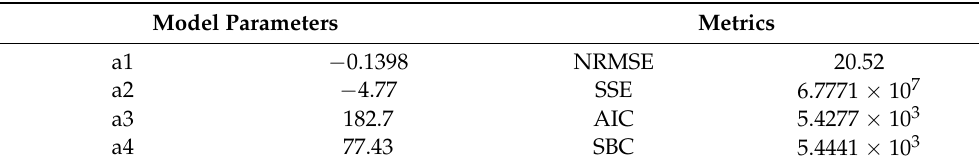
Table 12. Overview of the parameters of the created custom model and performance metrics of